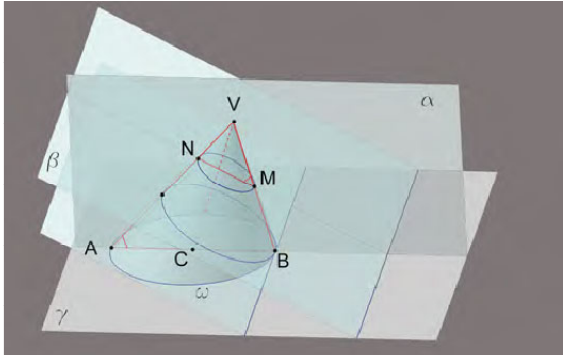
Figure 9. Theorem of Apollonio: sections of an oblique cone